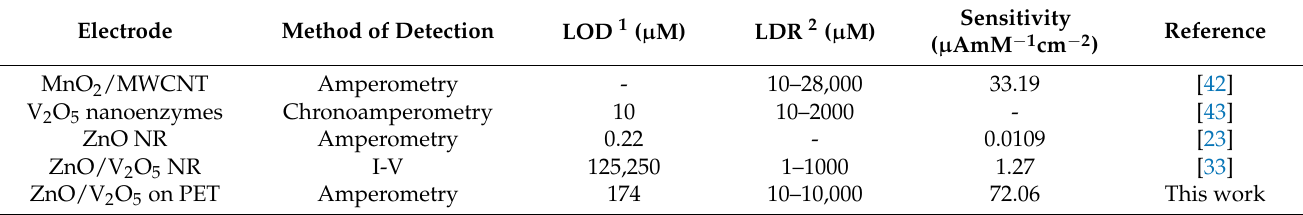
Table 1. Comparison of glucose sensing ability of ZnO/V 2 O 5 electrode with previously published for sensor application.